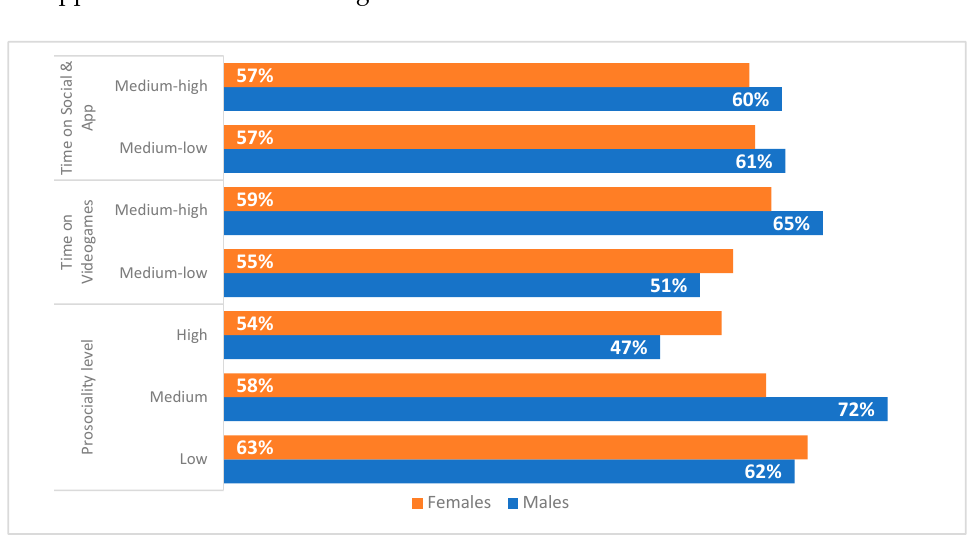
Figure 4. Levels of adherence to female gender roles by sex (% of medium and high levels by school grade, district, parental occupational status and parental level of education).